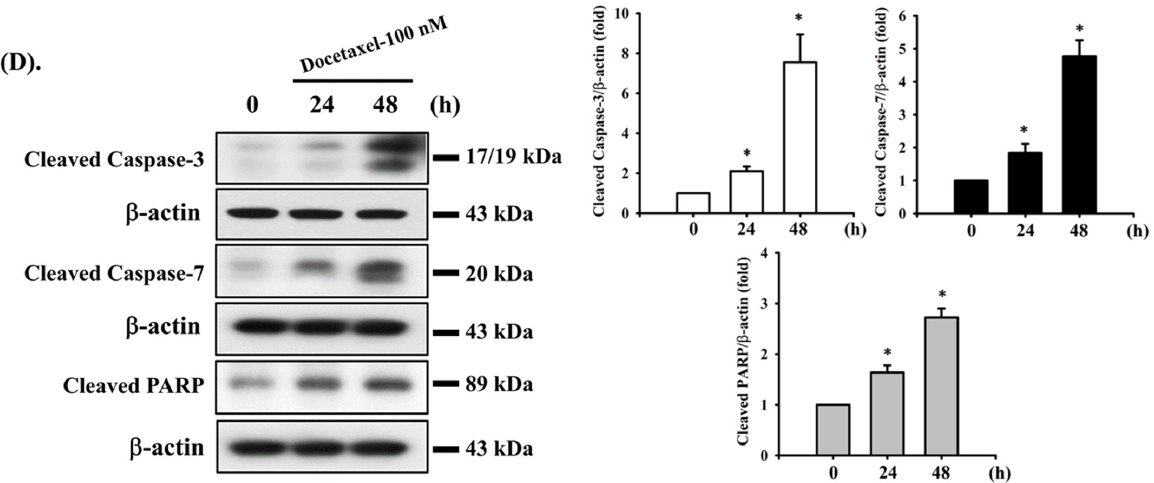
Figure 1. Effects of docetaxel on cell viability and apoptosis in human tongue squamous carcinoma SAS cells. ( A ) Cells were treated with docetaxel (100 and 300 nM) for 48 h. The morphological changes were observed using inverted phase-contrast microscopy (magnification × 200; scale bar = 100 µ m). ( B ) Cells were treated with docetaxel (10–300 nM) for 24 and 48 h. The cell viability was determined by MTT assay. ( C ) Cells were pretreated with or without Z-DEVD-FMK (10 μ M) for 1 h, and then treated with docetaxel (10 and 100 nM) for 24 or 48 h. The caspase-3 activity was determined us- ing a caspase-3 activity assay kit. ( D ) Cells were treated with docetaxel (100 nM) for 24 and 48 h. The cleaved caspase-3, caspase-7, and PARP protein expression levels were determined by Western blot assay. Data in ( B , C ) are presented as the means ± SD of four independent experiments with triplicate determination. Results are shown in ( D ) with representative images, and quantification was performed by densitometric analysis. Each presented bar is the mean ± SD of three indepen- dent experiments. Statistical analysis was performed with one-way ANOVA analysis followed by Tukey’s post hoc test. * p < 0.05 compared with vehicle control. # p < 0.05 compared with